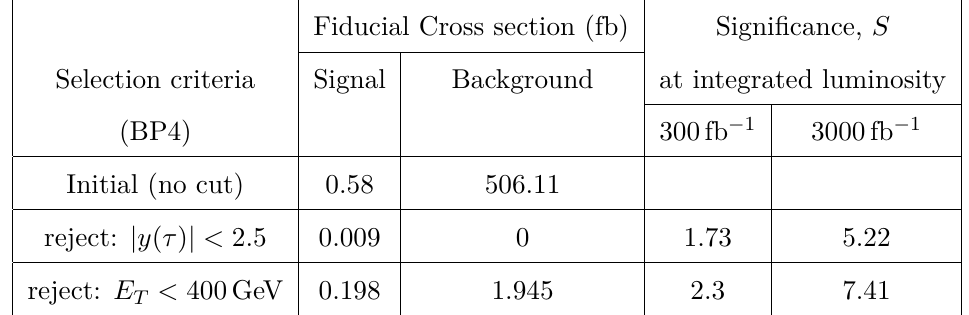
H − → ν τ ν τ τ + τ − ) and the SM background 2 2